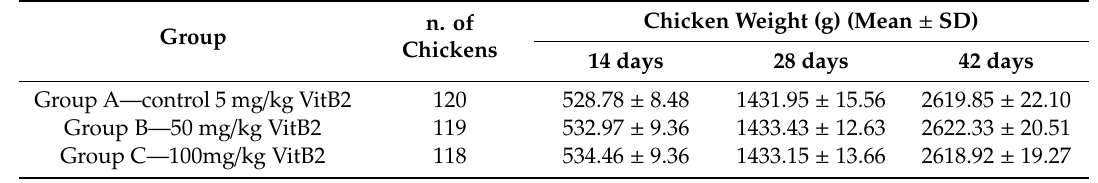
Table 1. Body weight (g) of Ross 308 female broiler chickens at di ff erent age of life in relation to di ff erent groups. Total number of birds that survived the whole trial is reported for each group. n. of Group